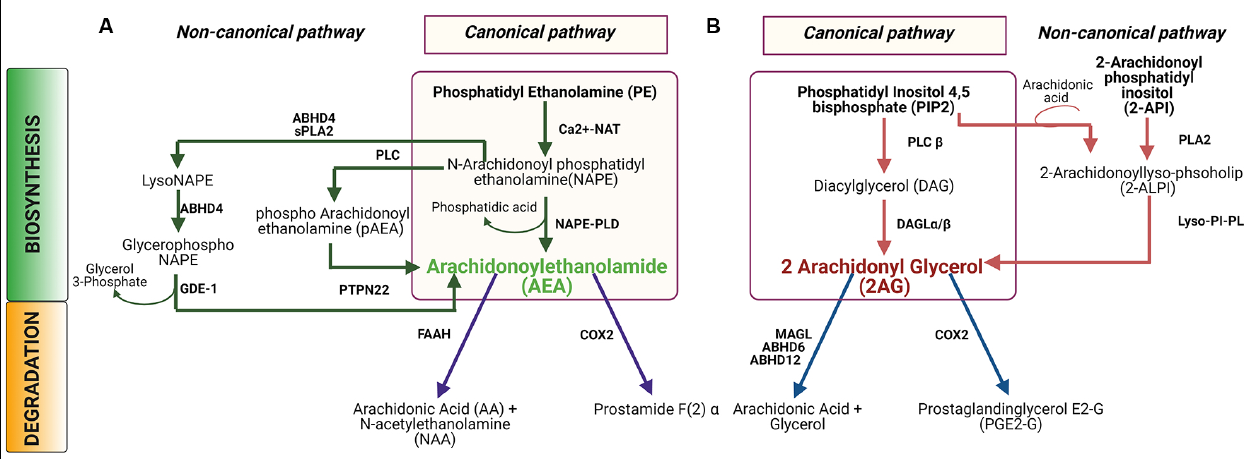
FIGURE 1 | Biosynthesis and degradation of N-arachidonoyl ethanolamine (AEA) and 2-arachidonoyl glycerol (2AG). (A) In the canonical pathway for AEA synthesis and catabolism, an N-acetyl group is added to phosphatidyl ethanolamine (PE) to produce N-arachidonoyl PE, or NAPE, which is then converted to AEA by the enzyme NAPE-PLD. In a non-canonical pathway, NAPE can be hydrolyzed by PLC to produce pAEA, and subsequently dephosphorylated by PTPN22N to produce AEA. Alternatively, NAPE can be converted to lyso-NAPE by the catalytic activity of either ABHD4 or sPLA2, and subsequently, lyso-NAPE is hydrolyzed by ABHD4 and GDE-1 to produce AEA. AEA is hydrolyzed by fatty acid amide hydrolase (FAAH) to produce AA and NAA or, AEA can be oxidized by COX2 to produce prostamide F(2) α . (B) In the canonical biosynthesis pathway for 2AG, PIP2 is hydrolyzed by PLC β to DAG which is subsequently hydrolyzed by DAGL to produce AG. In the non-canonical pathway, 2-ALPI is synthesized from either PIP2 or 2-API, which is subsequently hydrolyzed by lyso-PI-PLC to generate 2-AG. Degradation of 2AG occurs by hydrolysis by either MAGL or ABHD6 or ABHD12 to produce arachidonic acid and glycerol. Alternatively, 2AG can be oxidized by COX2 to generate to PGE2-G. Abbreviations: NAT, N-acetyltransferase; NAPE-PLD, N-acyl phosphatidylethanolamine-specific phospholipase D; PLC, Phospholipase C; PTPN22, Protein tyrosine phosphatase, non-receptor type 22 (lymphoid); ABHD4, α / β -Hydrolase domain containing 4; sPLA2, Secretory phospholipases A2; GDE-1, Glycerophosphodiester phosphodiesterase-1; FAAH, Fatty acid amide hydrolase; COX2, Cycloxygenase2; DAGL, Diacylglycerol lipase; Lyso-PI-PLC, Lyso phosphatidyl inositol phospholipase C; MAGL, Monoacylglycerol lipase; ABHD6, α / β -Hydrolase domain containing 6; ABHD12, α / β -Hydrolase domain containing